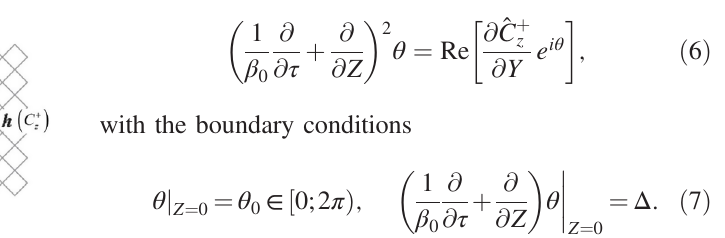
FIG. 1. (a) Scheme of an oversized SWO with 2D corrugated structure. Directions of propagation of the partial wave fluxes and tubular electron beam are shown. (b) Diagram illustrating coupling of partial waves at the 2D